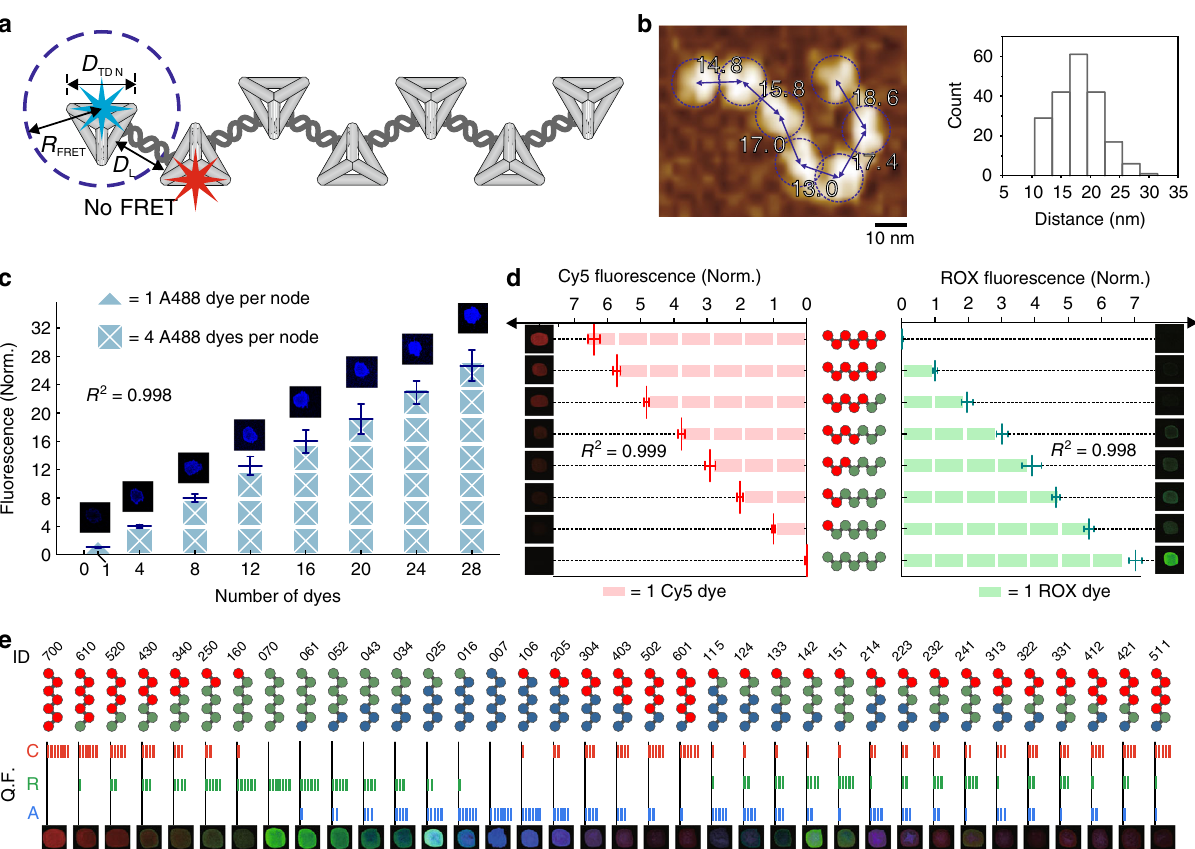
Fig. 3 FDFs encode quantised fl uorescence states. a Schematic illustration of the FDF structure with spatial control of fl uorophores. b Representative AFM image of a two-way FDF ( F 2,3 ) structure, and statistical distribution of the internode distance of the F 2,n structures ( N = 200). TDNs are marked with dashed circles. Measured distances between nodes (from centre to centre) are marked with numbers. c Correlation between fl uorescence intensity and the copy number of A488 on the two-way FDF. Embedded images are fl uorescence images of droplets containing corresponding FDFs in pseudocolour. d Correlation between fl uorescence intensity and the copy number of ROX and Cy5 anchored on the F 2,3 structures. Embedded images are fl uorescence images of droplets containing corresponding FDFs in pseudocolour. Error bars indicate standard deviations from three independent tests. e 36 FDF barcodes encoded with different fl uorophore combinations, which can be decoded by fl uorescence spectroscopy/microscopy. The three-digit IDs refer to the numbers of Cy5, ROX and A488 in a single FDF structure (e.g., “ 124 ” refers to the presence of 1 Cy5, 2 ROX and 4